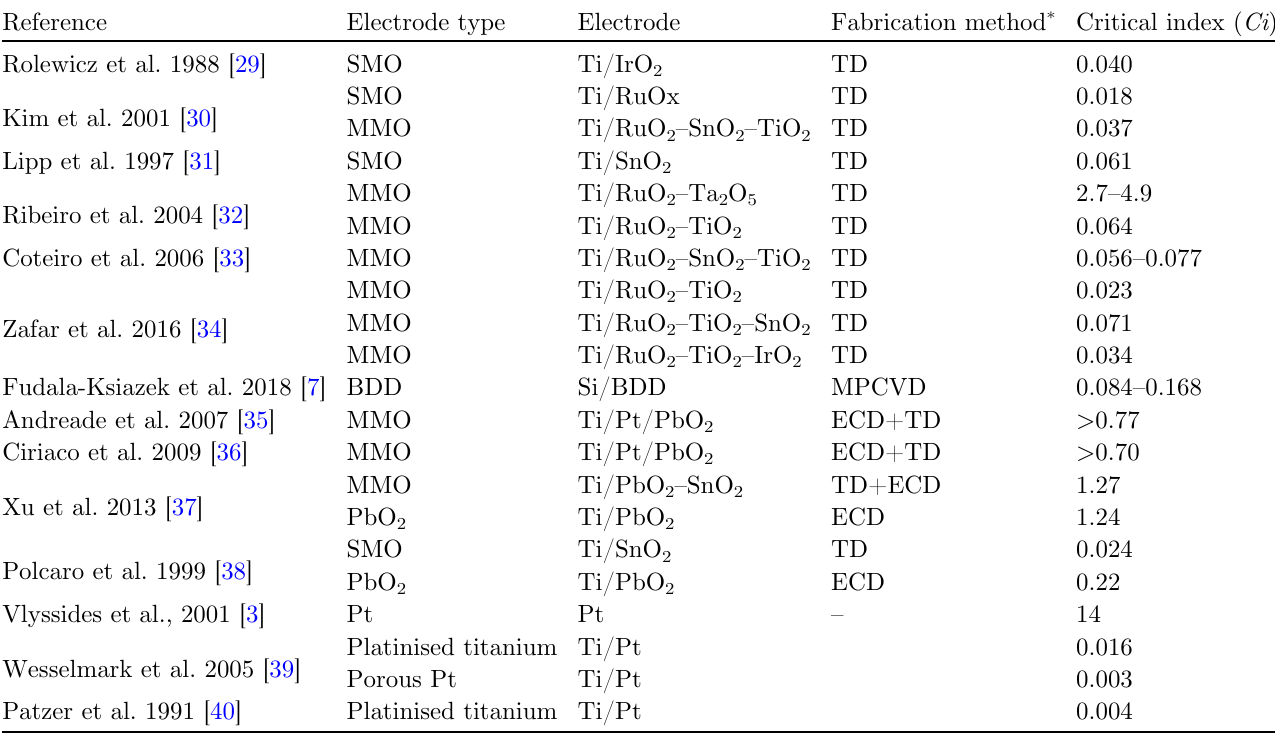
Table 2. Electrode